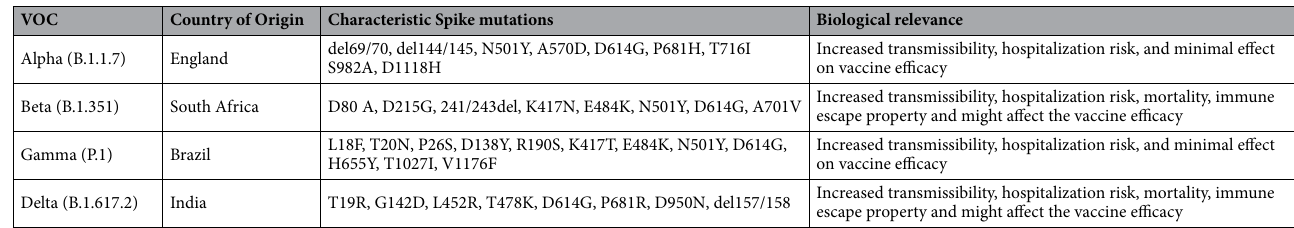
Table 1. SARS-CoV-2 variants of concerns: defining mutations in the spike